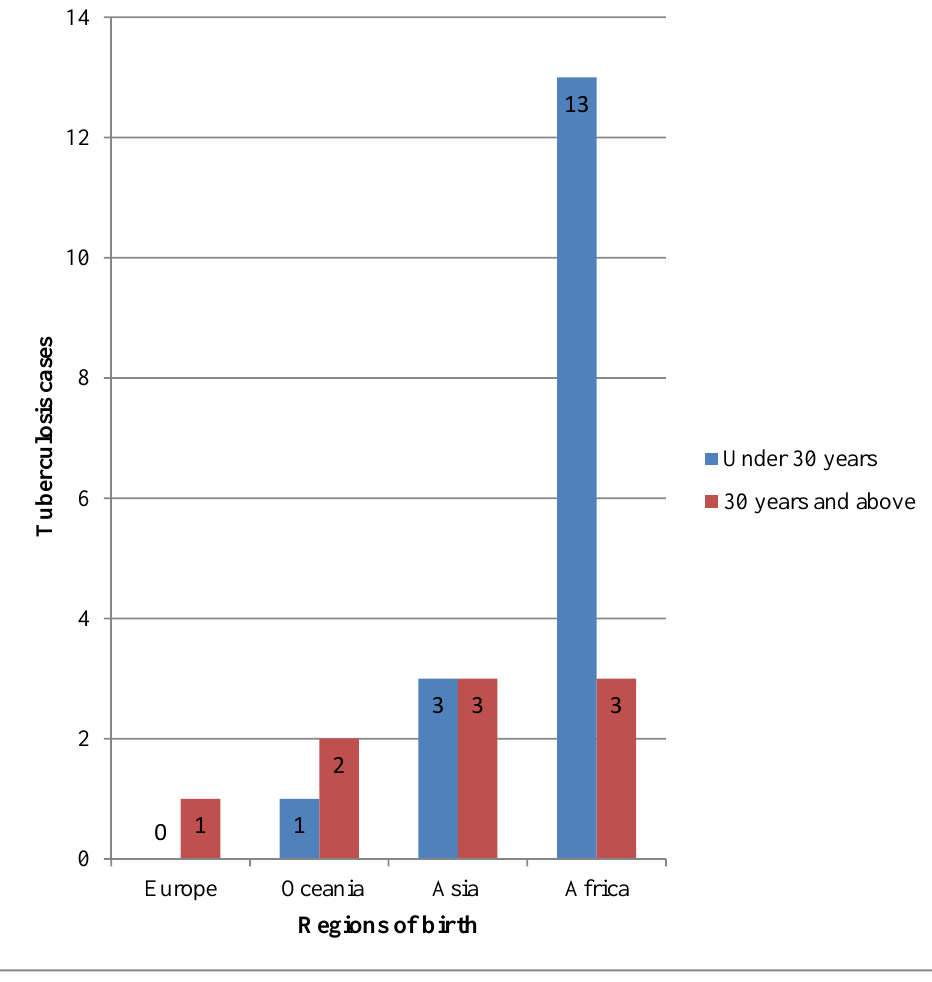
Figure 2. Regions of birth and ages.